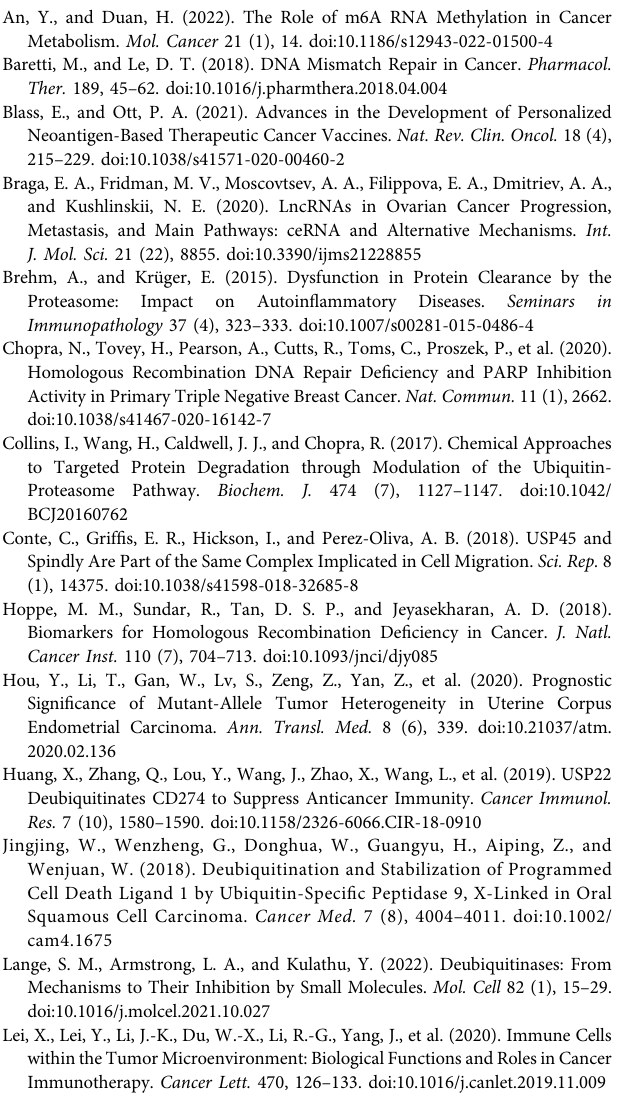
Supplementary Table S1 | Prognostic Value of Single CpG of the USP45 gene in pan-cancer by MethSurv platform. Supplementary Figure S1 | Correlation analysis of USP45 with OS and RFS in patients with different types of tumors. The correlation of USP45 with OS in patients with BLCA (A) , EAC (B) , KIRC (C) , PCPG (D) , and RFS in patients with UCEC (E) , LIHC (F) , BRCA (G) , HNSC (H) , LUAD (I) , UCEC (J) were analyzed. Supplementary Figure S2 | Correlation analysis among USP45, miRNA with lncRNA in ceRNA network. In COAD (A) and PRAD (B) , the correlation among USP45, miR-30e-5p with AL137003.2 was analyzed. In KICH (C) , SARC (D) , LGG (E) , THCA (F) and PRAD (G) , the correlation among USP45, miR-425-5p with